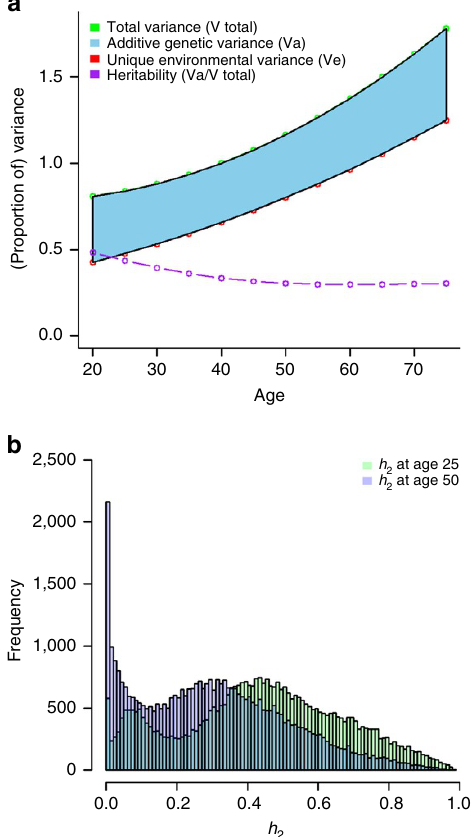
Figure 5 | Heritability of DNA methylation at sites with significant interaction between age and genetic variance or age and environmental variance. ( a ) Total variance of DNA methylation, additive genetic variance, unique environmental variance and heritability plotted against age, based on estimates obtained in interaction models on data from 2,603 individuals. ( b ) Histogram of heritability at age 25 (green) and at age 50 (purple) for 39,455 CpGs with significant interaction between age and genetic variance or between age and unique environmental variance. Dark blue denotes the overlap of green and purple